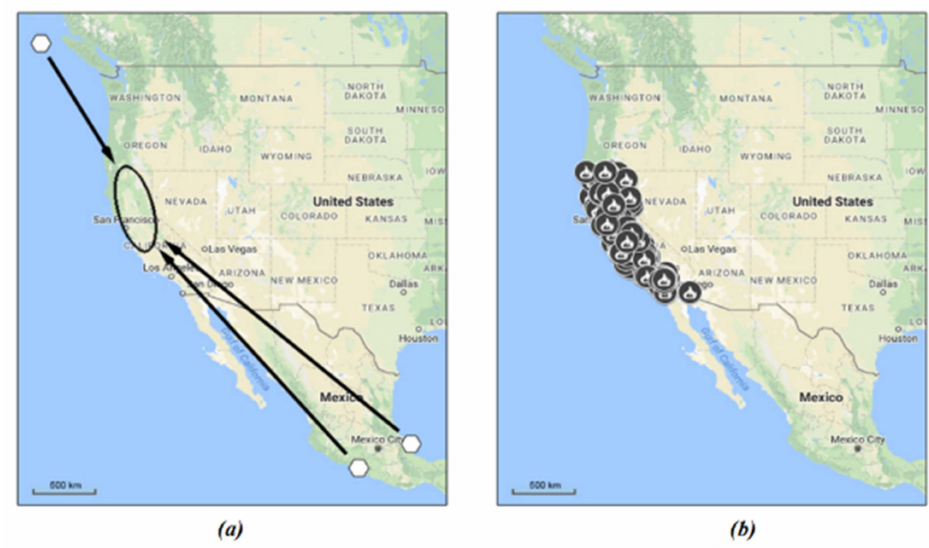
Figure 18. Unexpected consequences of disastrous floods in the USA (2017). ( a )—white hexagons–the earthquakes epicenters; black oval–the flooding area; ( b )—the wildfires seats.